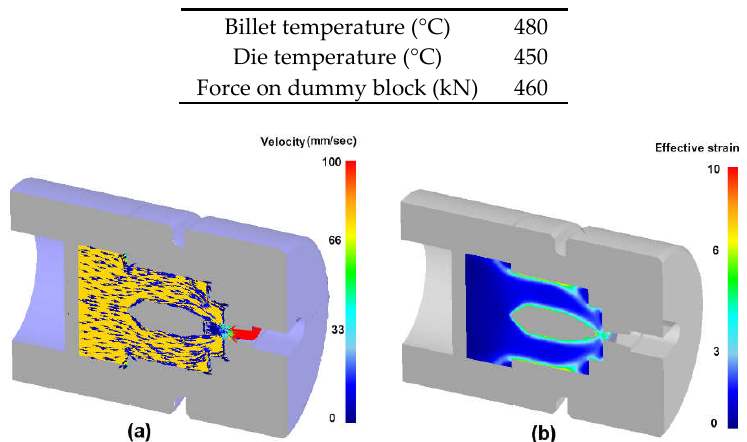
Figure 4. FE simulation results: ( a ) velocity field and ( b ) effective strain field.